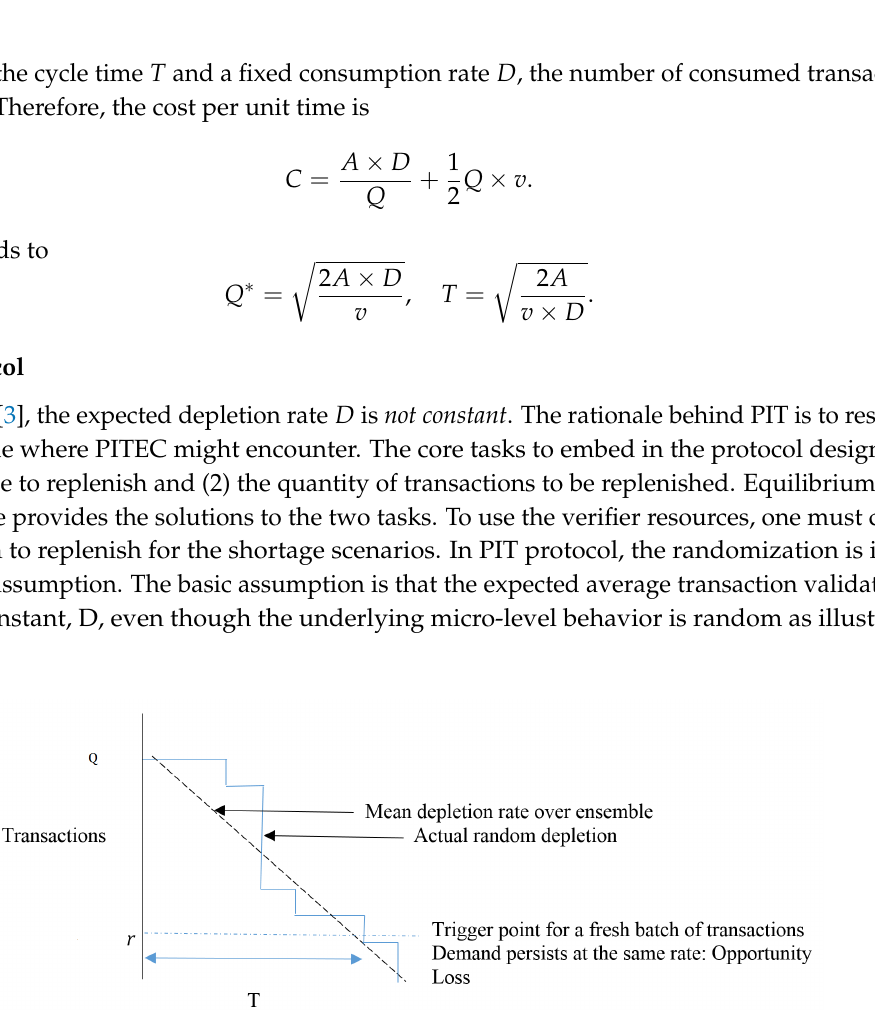
Figure 1. Q on the Y axis is the number of transactions to be verified while X axis is the time. T represents the time for a cycle. D is the mean depletion rate (the dashed line) of random rates. When less than r transactions left unconsumed, the trigger is